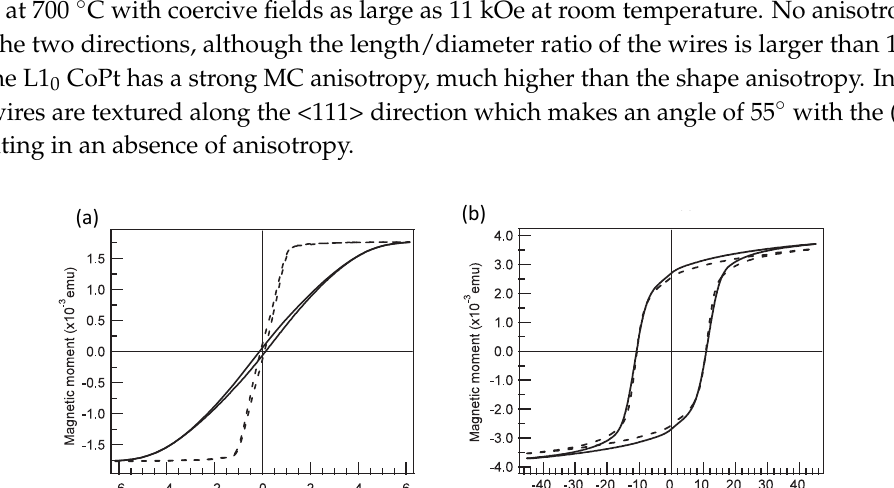
Figure3. 80nmdiameterCo 0 . 47 Pt 0 . 53 orderednanowiresafter Figure 2. As-deposited nanowires: ( a ) cross-sectional SEM image Figure 8. Hysteresis loops measured at 300 K in arrays of Co 47 Pt 53 nanowires with the field applied annealingat700˚C;( a )XRDpattern;thesuperstructurepeaks,as of 80nm diameter Co x Pt 1 nanowires electrodeposited in the (001)or(110),revealanorderedphaseofthealloy;( b )room − x supported alumina template; ( b ) XRD patterns of the nanoporous parallel (solid line) and perpendicular (dashed line) to the wires. ( a ) As-deposited sample and temperaturehysteresisloops. Thecurveswereobtainedwiththe substrate and the as-deposited Co x Pt 1 nanowires showing an fcc magneticfieldparallel(——)andperpendicular(- - - -)tothe − x structure with a preferred 111 growth orientation and wire’saxis. ( b ) annealed sample at 700 ◦ C. Note the different magnetic field scales in ( a ) and ( b ) (from [28]). ⟨ ⟩ ( c )correspondingmagnetizationcurvesmeasuredwiththemagnetic field parallel (——) and perpendicular (- - - -) to the wire’s axis at Figure adapted from ref. [28] with permission of the room temperature. (This figure is in colour only in the electronic version) the Co 0 . 47 Pt 0 . 53 sample is found to be a tetragonal lattice (L1 0 phase) with a c/a ratio of 0.979 (table 1). Figure2. As-depositednanowires:( a )cross-sectionalSEMimage of80nmdiameterCo x Pt 1 nanowireselectrodepositedinthe − x supportedaluminatemplate;( b )XRDpatternsofthenanoporous substrateandtheas-depositedCo x Pt 1 nanowiresshowinganfcc − x structurewithapreferred 111 growthorientationand ⟨ ⟩ ( c )correspondingmagnetizationcurvesmeasuredwiththemagnetic fieldparallel(——)andperpendicular(- - - -)tothewire’saxisat roomtemperature.